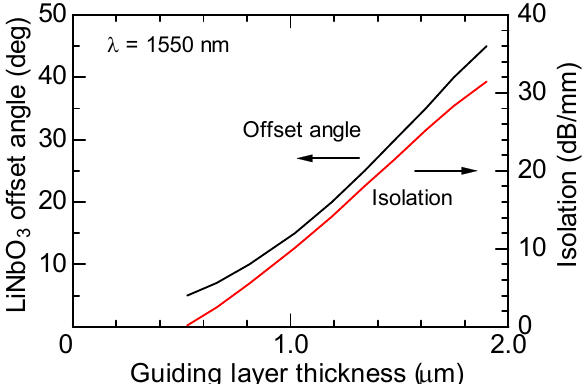
cladding layer 3